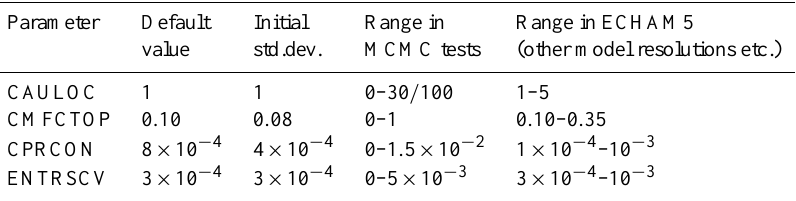
Table 2. Parameter values applied in the MCMC tests. The first column gives the default values for resolution T21L19, the second column the initial estimate of one-sigma uncertainty used to initialize the MCMC chain, the third column minimum and maximum parameter values allowed, and the fourth column the range of parameter values applied in standard ECHAM5. The upper limit of parameter CAULOC was 100 for the first four experiments, but it was reduced to 30 for the J G + ZONAL experiment, when it was realized that all values of CAULOC higher than about 30 produce identical